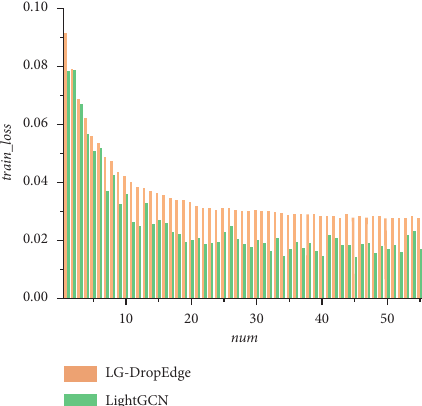
Figure 3: Train_loss comparison at the same ndcg level (Yelp2018).